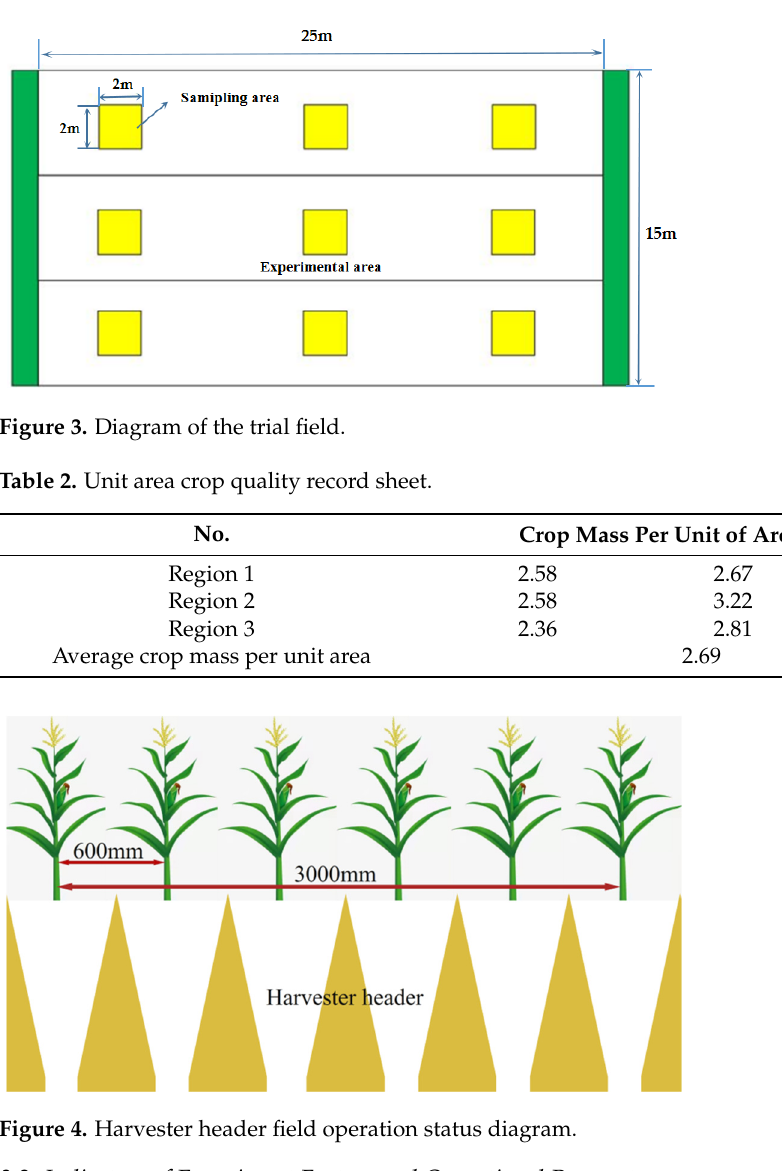
Figure 4. Harvester header field operation status diagram.